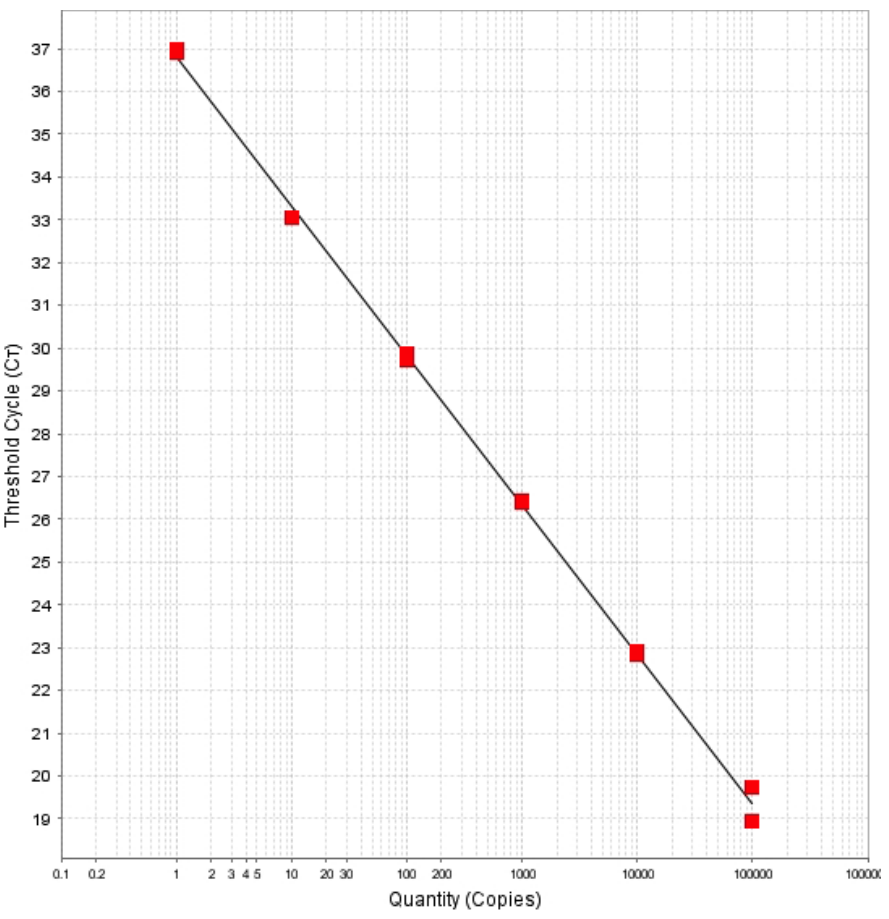
Figure 3. Standard curve obtained with 10 5 , 10 4 , 10 3 , 10 2 , 10, 1, 0.1 and 0.01 genome units of L. interrogans serovar Pomona. The slope of regression line between threshold cycle and leptospiral DNA standards is −3.485, and R 2 is 0.999.